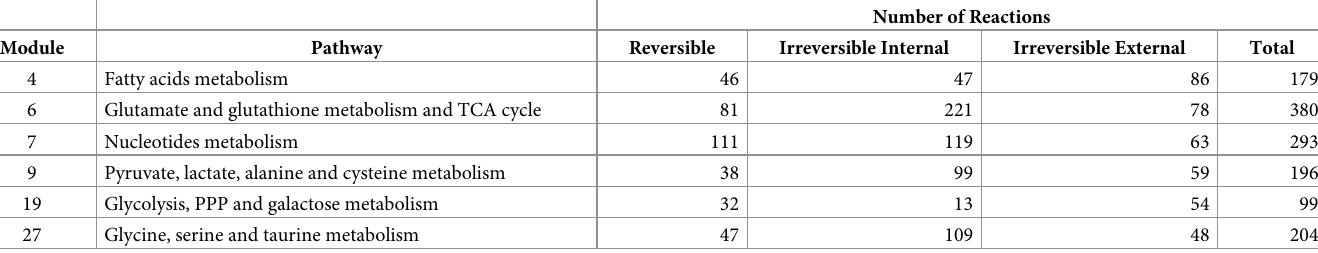
Table 2. Topologically independent modules of Recon 2.2. The remaining 1,168 structural reversible reactions, after removal of antiporter reactions, were grouped in 321 modules (see Table F in S1 Table for the full list of modules). Here features of the six largest modules are presented.